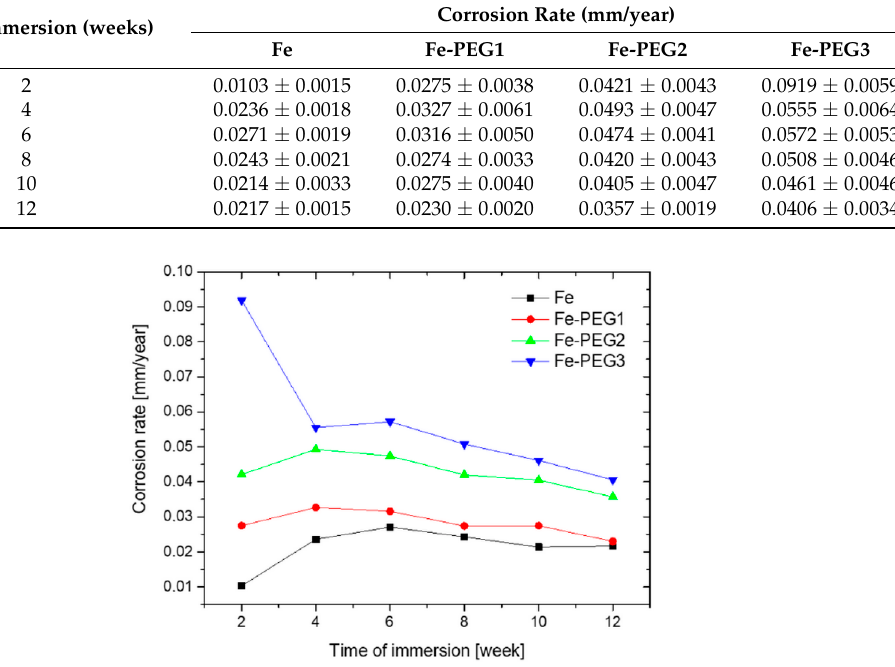
Figure 9. Corrosion rate of open cell iron samples with and without the PEG film obtained from immersion tests in Hanks’ solution.